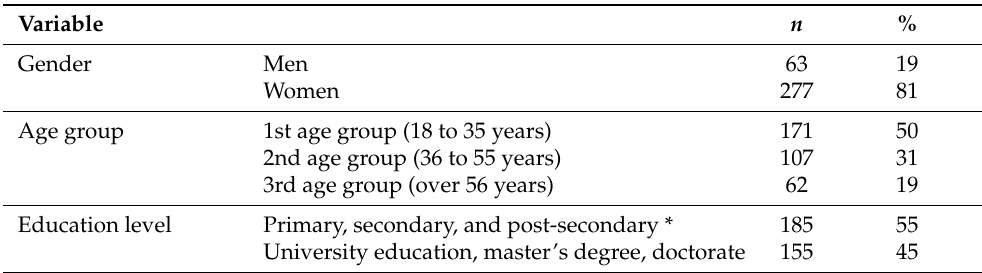
Table 2. Demographic data for the surveyed consumers ( n =